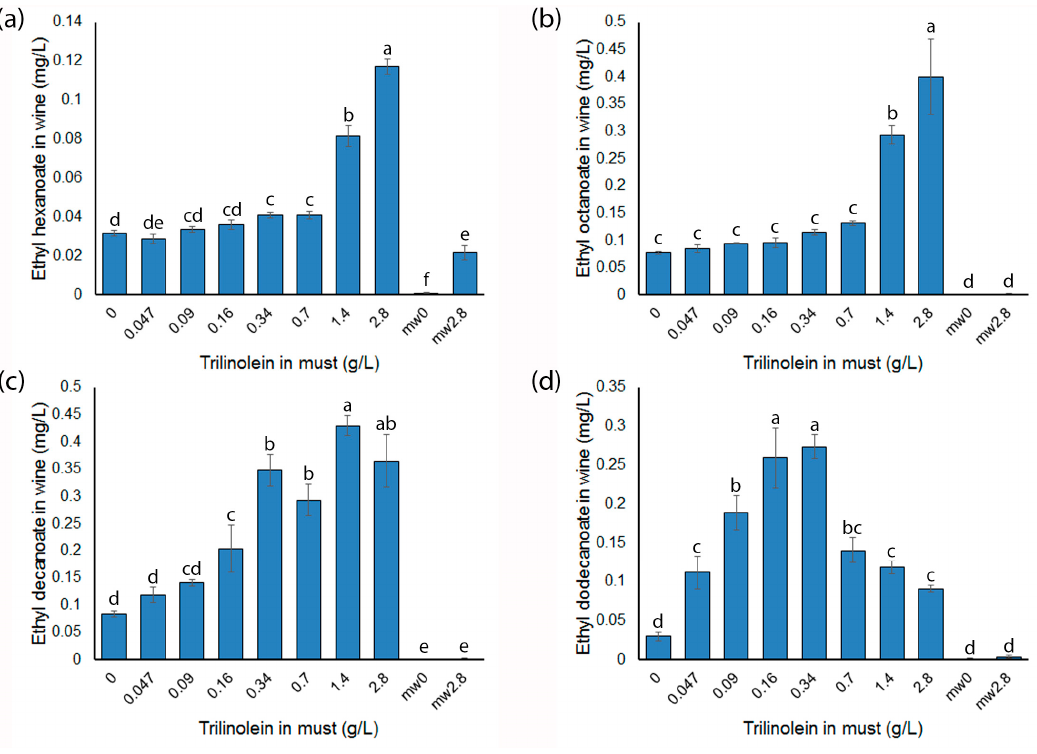
Figure 4. Concentrations of MCEE in wines prepared from model musts spiked with different concentrations of trilinolein. Values represent the mean concentration of analyte ( n = 3); error bars are the standard error; and different letters denote significant differences between samples at p < 0.05 using ANOVA followed by Duncan’s new multiple range test. ( a ) Ethyl hexanoate; ( b ) ethyl octanoate; ( c ) ethyl decanoate; ( d ) ethyl dodecanoate.